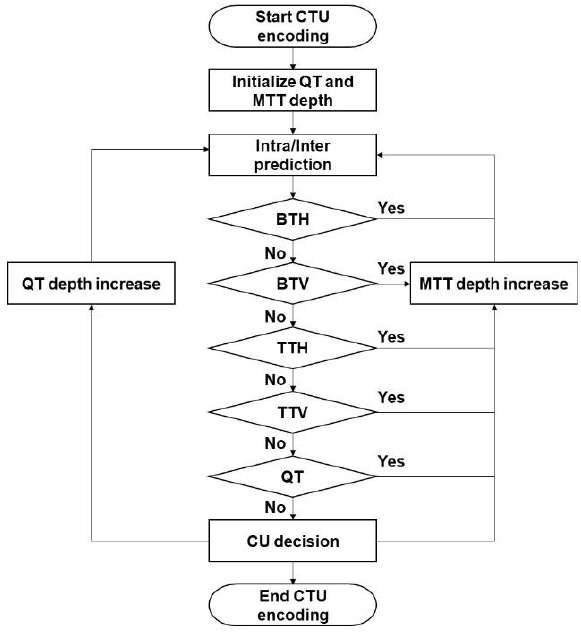
Figure 5. Flowchart of VVC/H.266 block partitioning.